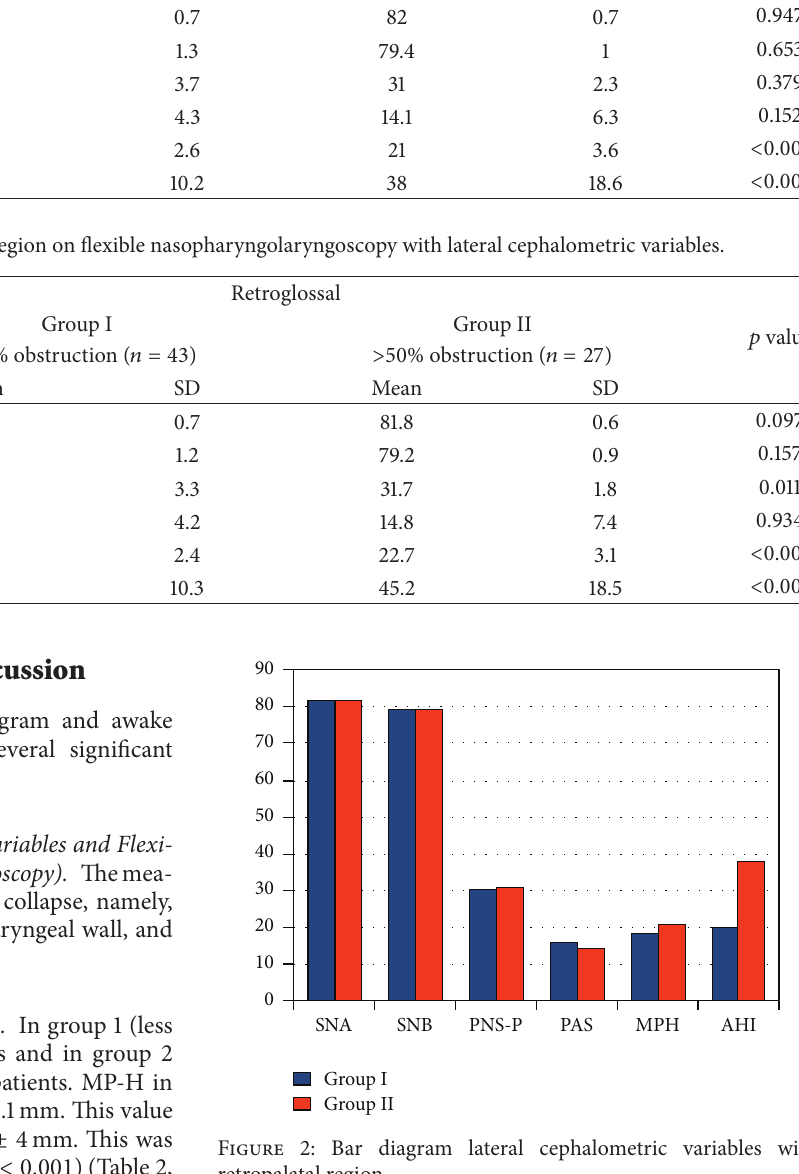
Lateral cephalogram indices